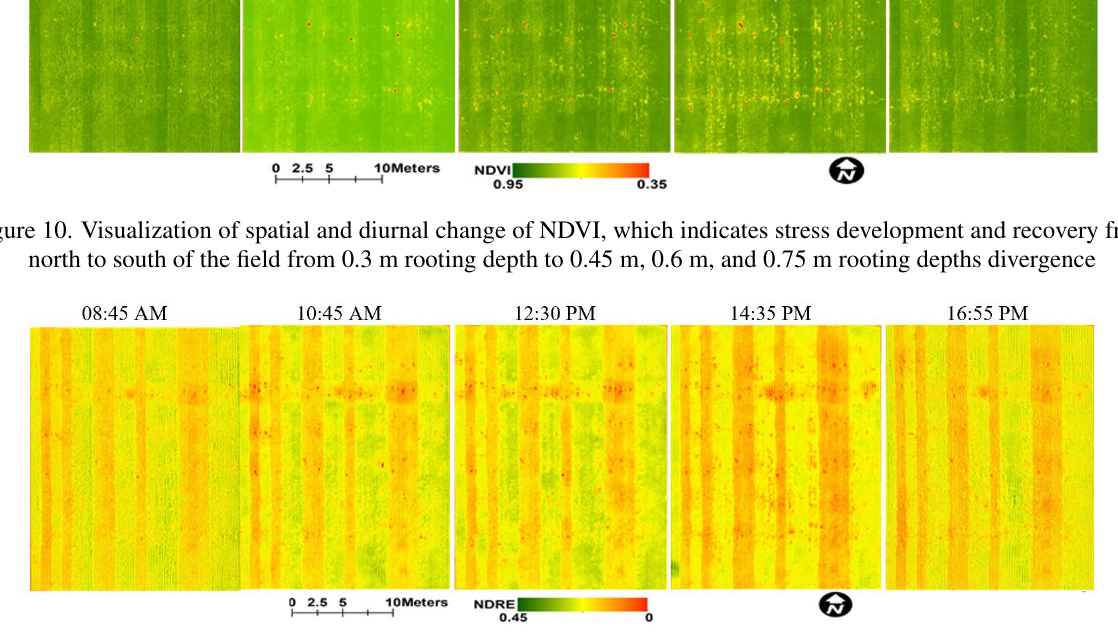
Figure 11. Visualization of spatial and diurnal change of NDRE, which indicates stress development and recovery from north to south of the field from 0.3 m rooting depth to 0.45 m, 0.6 m, and 0.75 m rooting depths divergence